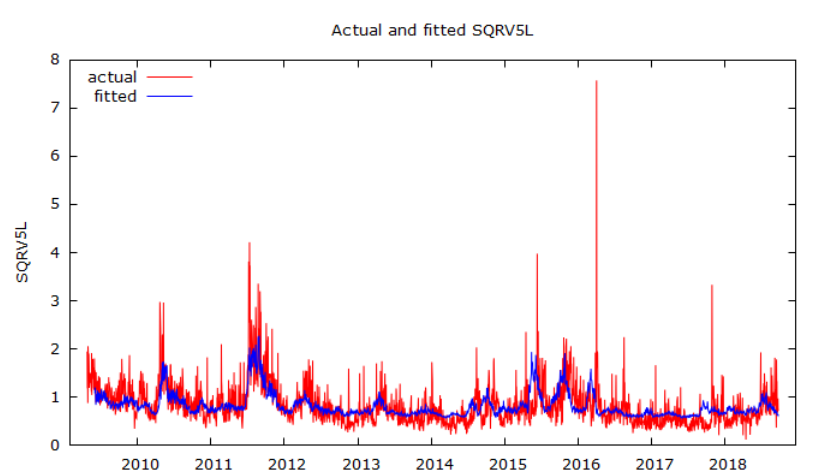
Figure 8. Plots of actual and fitted volatilities using lagged DMSQFTSERET as explanator.